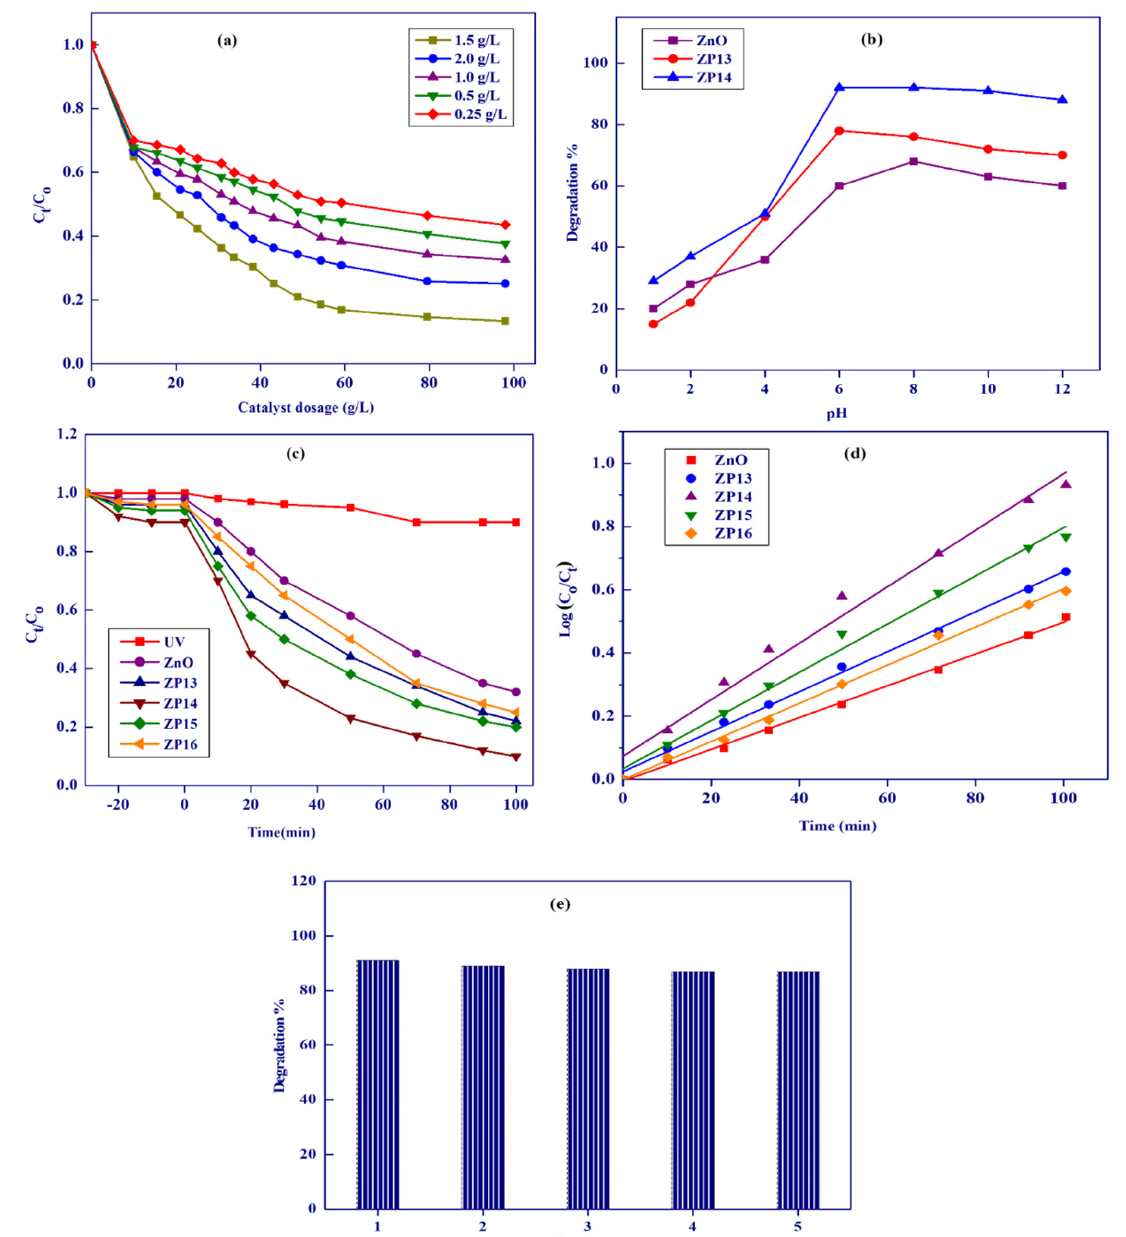
Figure 7. Effect of ZP14 dosage ( a ), effect of pH on activity of ZnO, ZP13, and ZP14 ( b ), photolysis and photocatalytic activity of ZnO, ZP13, ZP14, ZP15, and ZP16 ( c ), kinetics studies of ZP13 and ZP14 ( d ), and ZP14 reusability ( e ) for degradation of